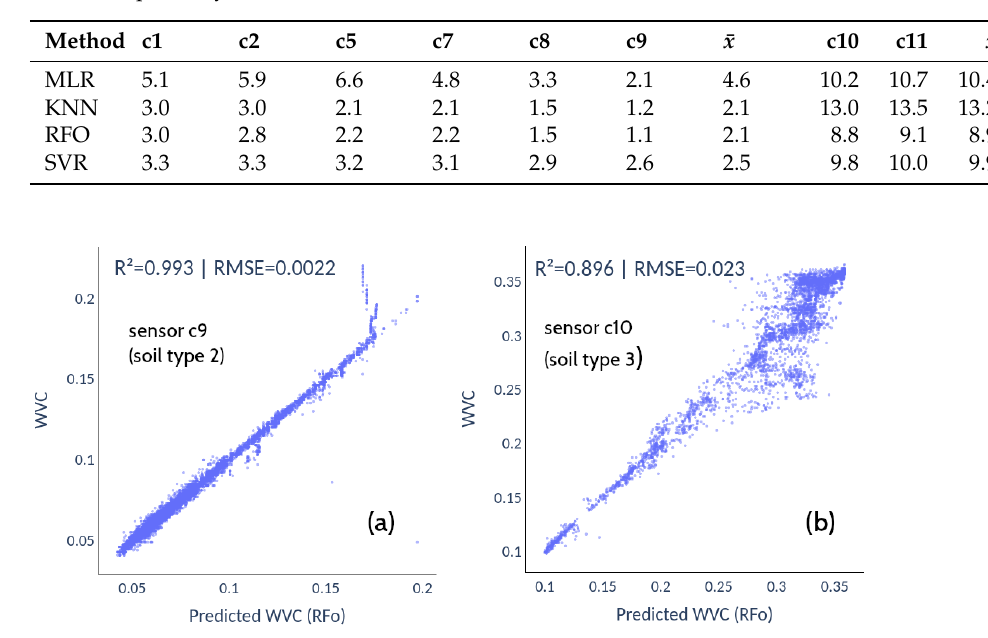
Figure 11. R 2 (crosses) and RMSE (circles) values for each sensor with MLR, KNN, RFO and SVR machine-learning calibrations for soil type 2 (sensors c1 to c9) and soil type 3 (sensors c10 and c11). Table 2. Relative RMSE for the different calibration methods for soil types 2 and 3 (sensors c1-c9 and c10-c11 respectively).